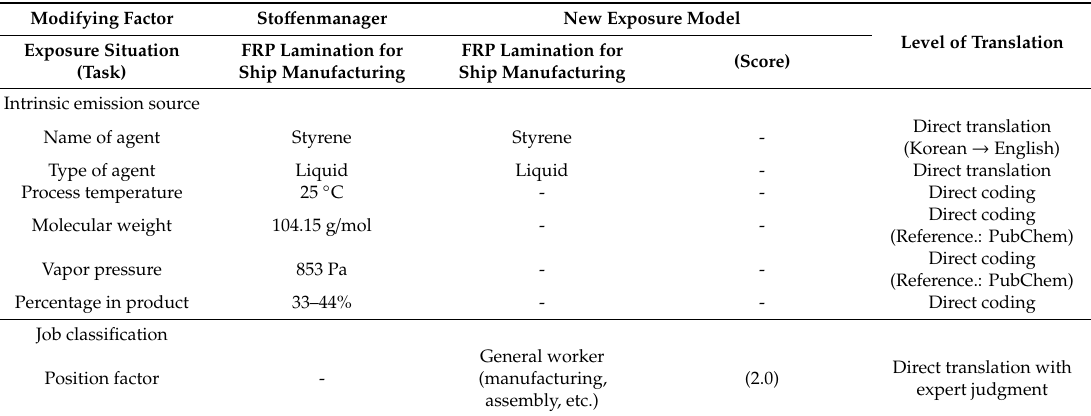
Table 3. Examples of modifying factors and associated scores entered in Sto ff enmanager and a new model with the level of translation using expert judgment in this